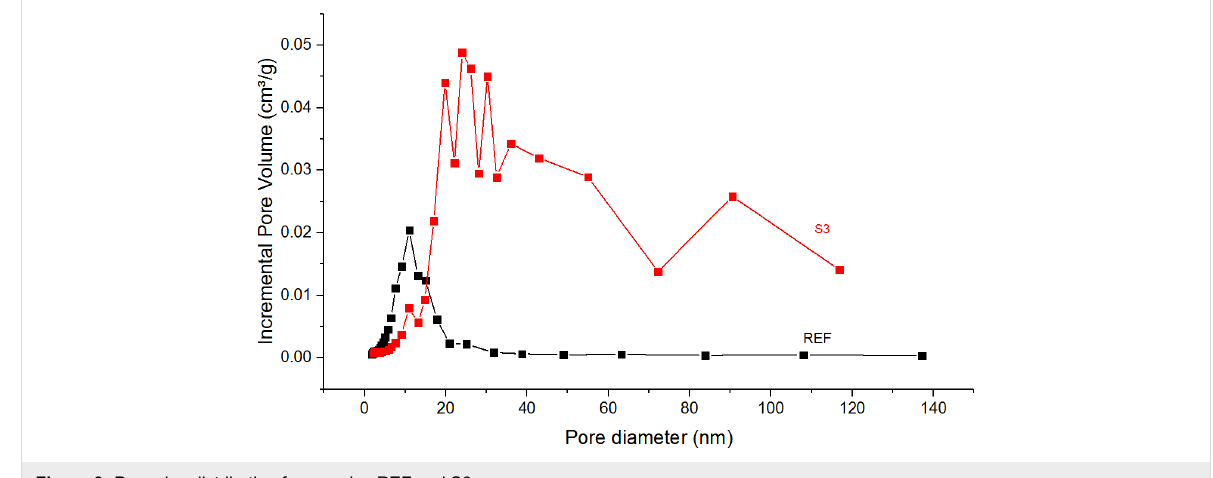
Figure 3: Pore size distribution for samples REF and S3.